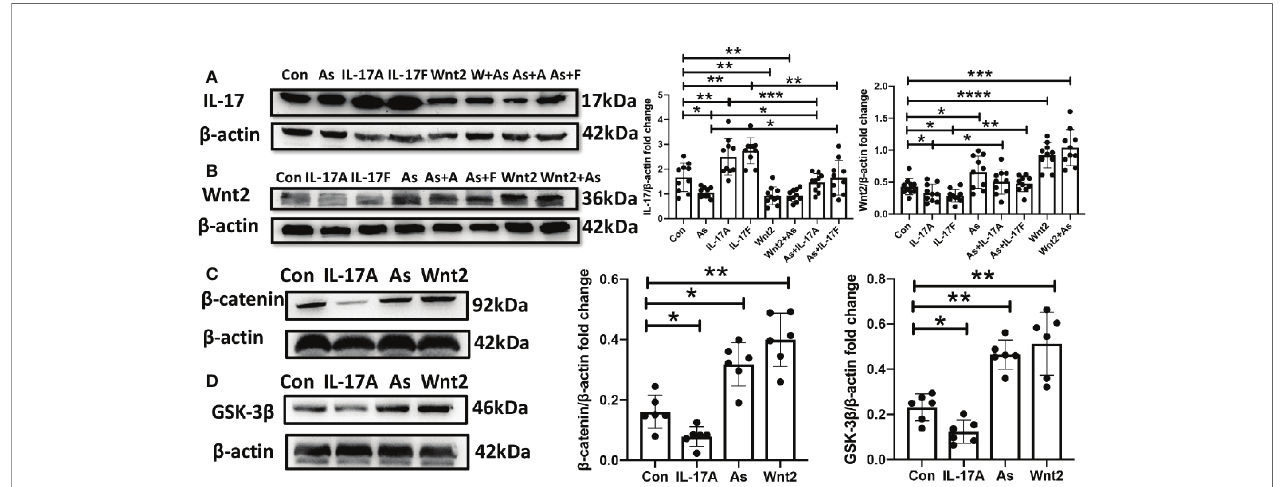
FIGURE 8 | The protein expression of NSCs was regulated by As IV, Wnt2-expressing virus, IL-17A and IL-17F. (A) IL-17 expression was downregulated by adding As IV and Wnt2-expressing virus, while upregulated by IL-17A and IL-17F. (B) Wnt2 expression was upregulated by adding As IV and Wnt2-expressing virus, while downregulated by IL-17A and IL-17F. The negative regulation by IL-17A and IL-17F was reversed by giving As IV and Wnt2-expressing virus . (C, D) The expression of b -catenin and GSK-3 b was decreased by administering IL-17A, while increased by giving As IV and Wnt2-expressing virus. n = 3, *p < 0.05, **p < 0.01, ***p < 0.001, ****p < 0.0001. Con, control; IL, interleukin; As, Astragaloside IV; NSCs, neural stem cells; GSK-3 b , Glycogen synthase kinase